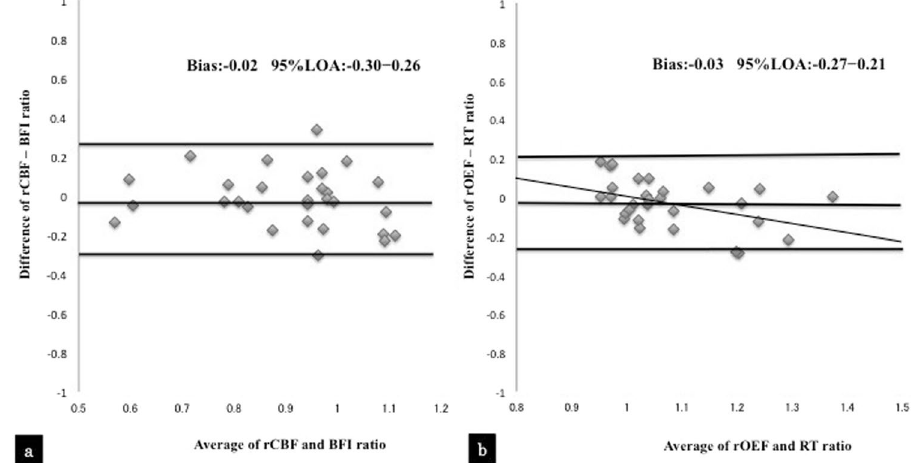
Figure 2. Brand-Altman analysis of the difference between the rCBF and BFI ratios versus the average of the rCBF and BFI ratios ( a ). Brand-Altman analysis of the difference between the rOEF and RT ratios versus the average of the rOEF and RT ratios ( b ).